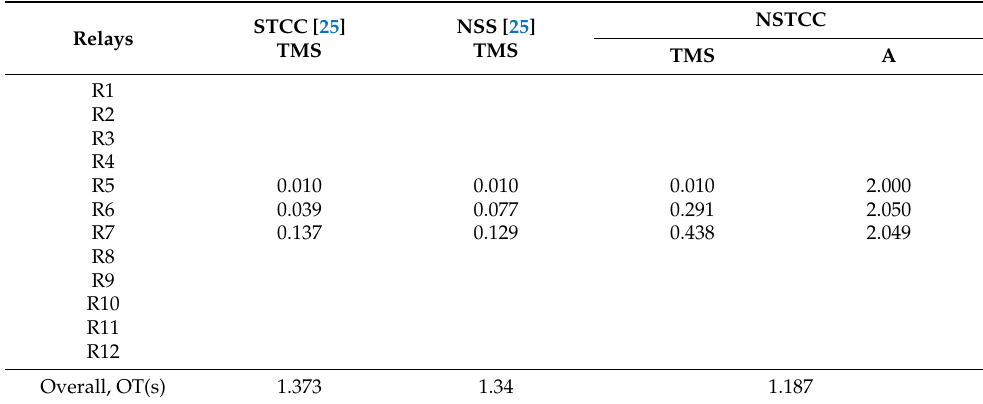
Table 5. The Overall OT for STCC, NSS, and NSTCC Curves in Radial IEEE 9-Bus—Mode